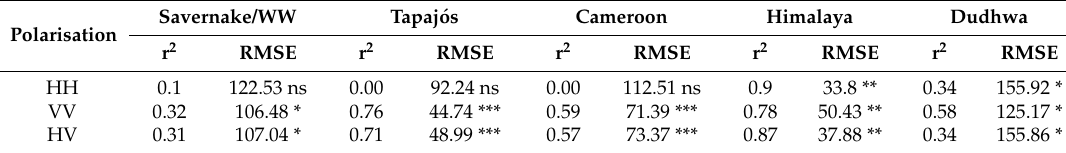
Table 7. Results of biomass regression models using MIMICS-I simulated S-band backscatter. r 2 is the coefficient of determination and RMSE is the root mean square error (t/ha) calculated using plots. Savernake/WW Tapaj ó s Cameroon Himalaya Polarisation